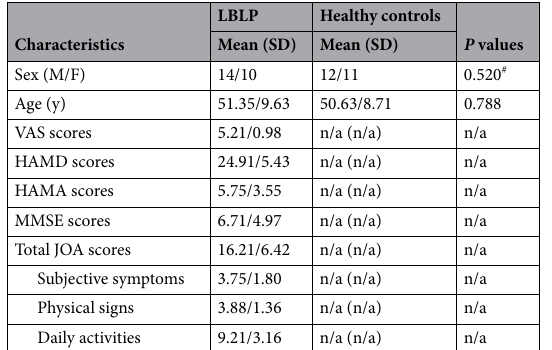
Table 1. Demographic data and clinical characteristics of the LBLP group and HCs. LBLP low back-related leg pain, F female, M male, n/a not available, SD standard deviation, JOA Japanese orthopaedic association, VAS visual analog scale, HAMD Hamilton depression rating scale, HAMA Hamilton anxiety scale, Mini-Mental State Examination. # Chi-squared tests.